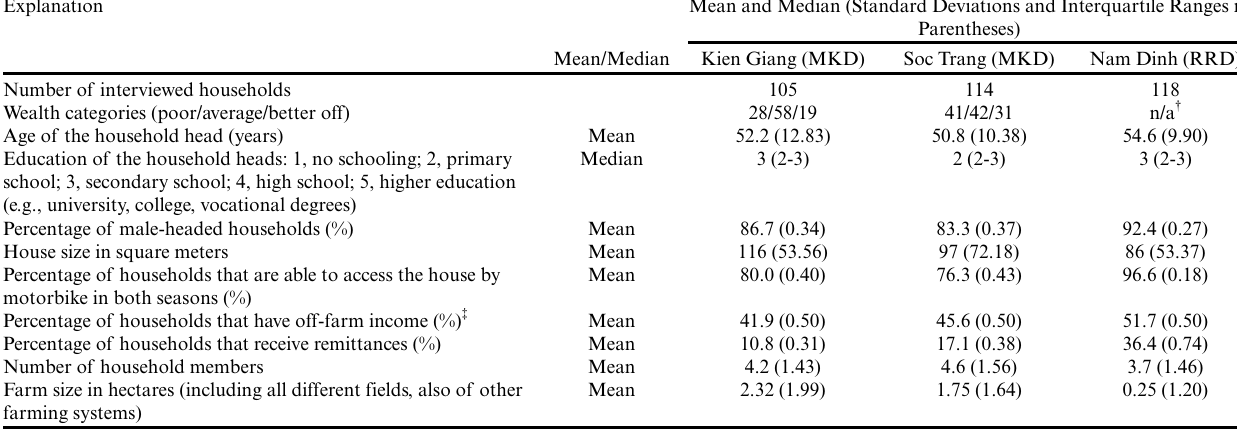
Table 3 . Characteristics of the interviewed households in the structured (Mekong Delta, MKD) and semistructured interviews (Red River Delta, RRD).